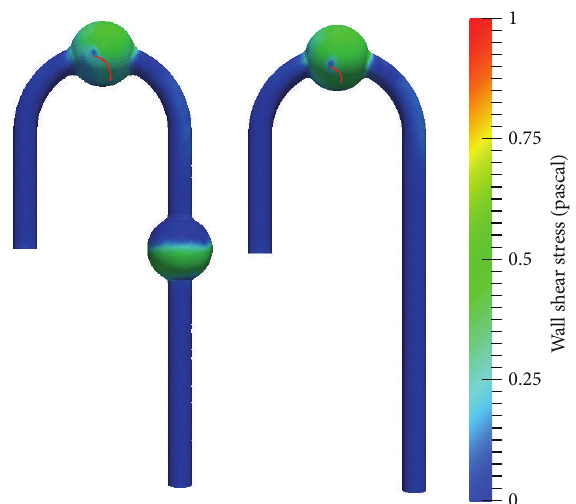
Figure11:Lowwallshearstresspointmovementpath(redline),left: DAA, right: AAA